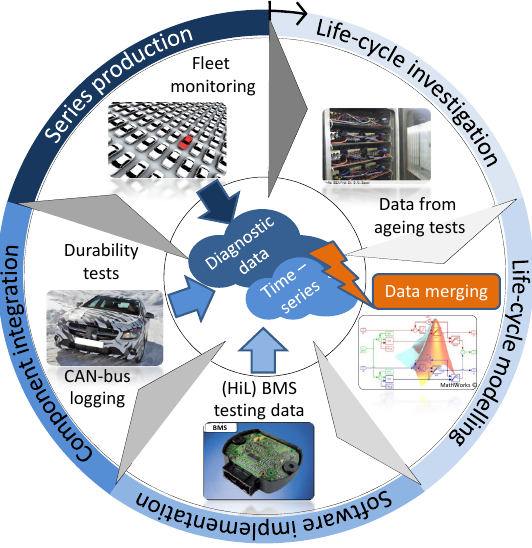
Figure 1. Development cycle for a lithium-ion battery in an automotive